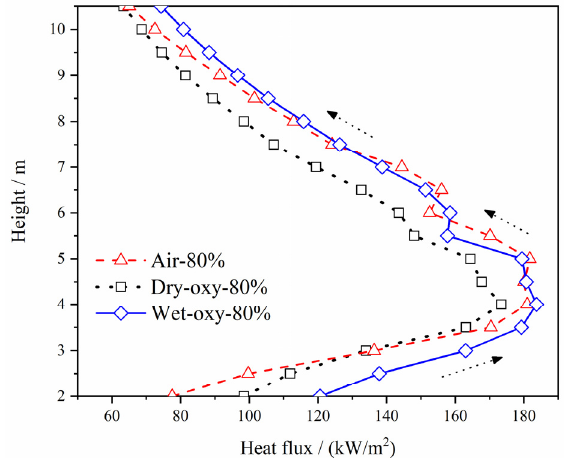
Figure 7. Heat flux distributions at the width of 2.36 m at 80% load in various combustion environ- ments. Table 4. Comparison of the average heat flux and temperature of the front wall in different cases.